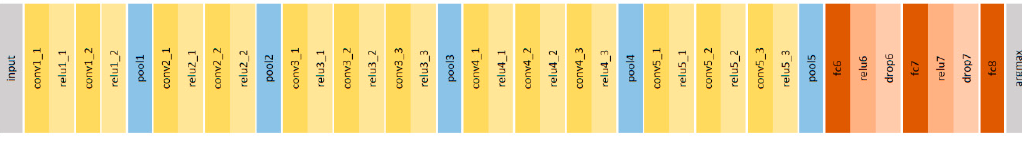
Figure 4. VGG16 feature extractor.